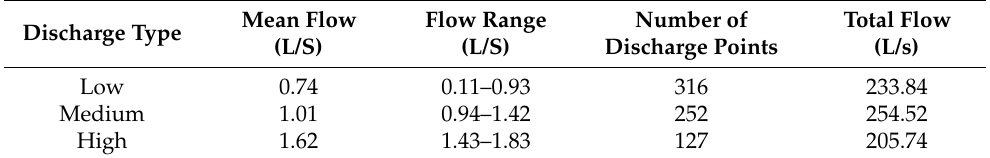
Figure 2. Location of wastewater discharges (red dots); the blue line represents the coastline, Google Earth image. Table 1. Discharge flows that were considered in the simulations.